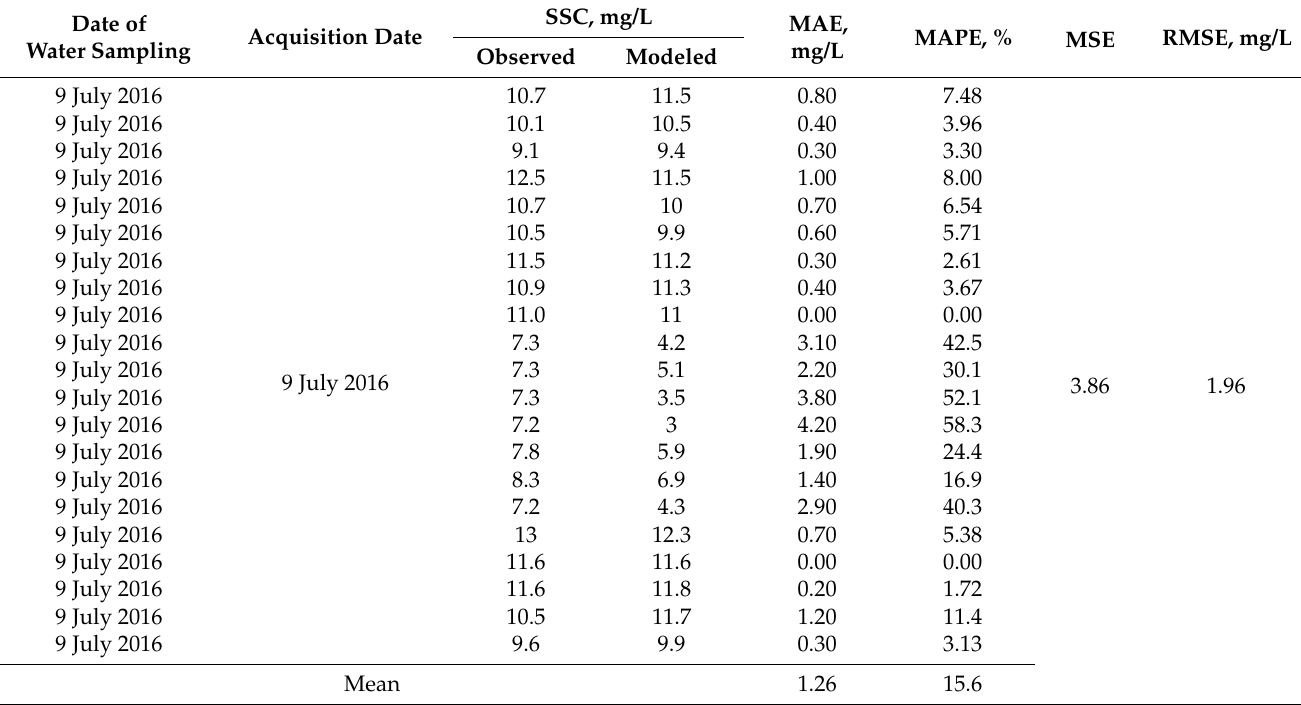
Table 5. Statistical comparisons between modeled SSC retrieved from satellite data by the “2020-model” and measured in situ